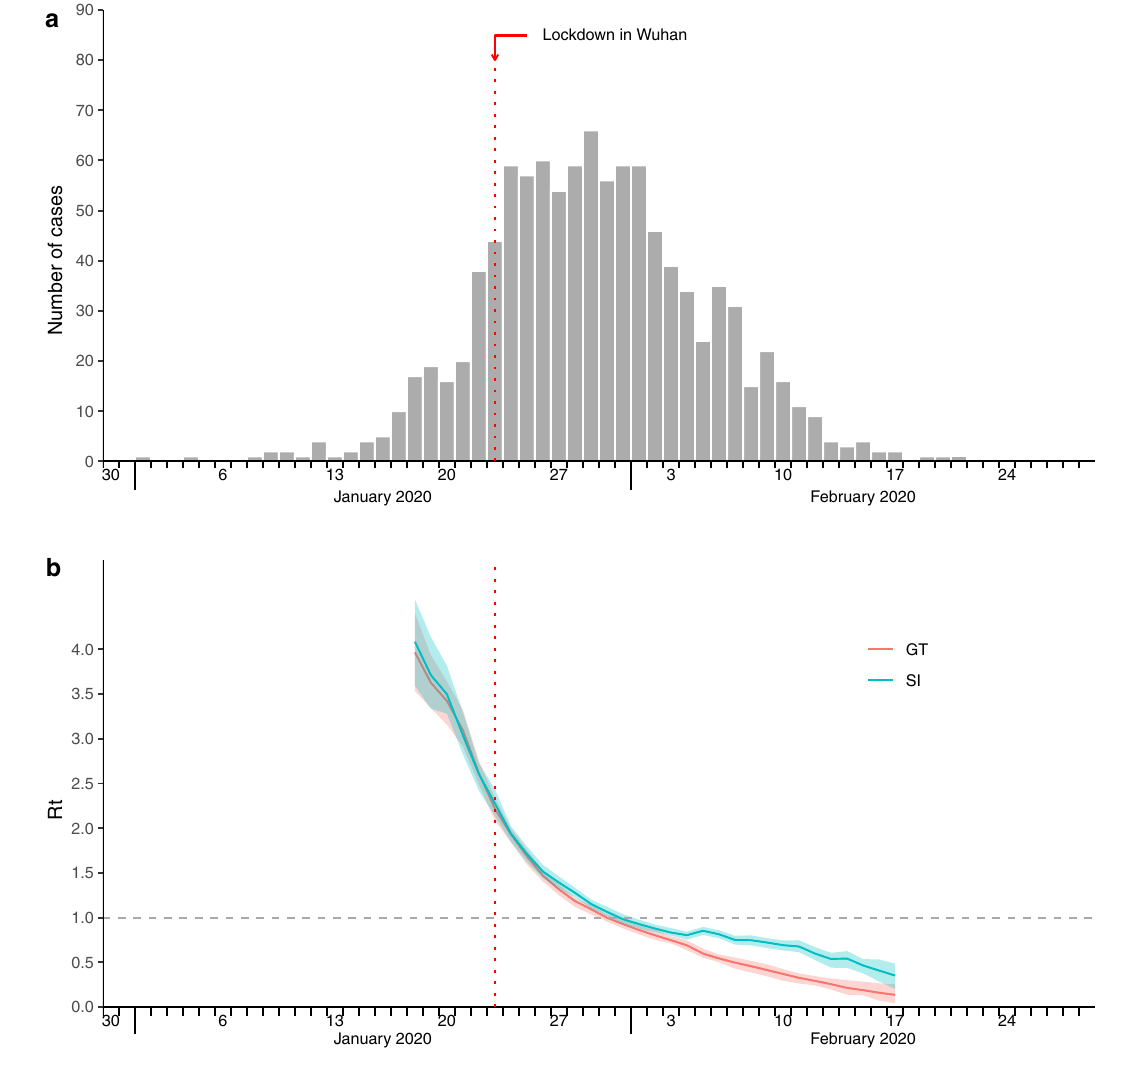
Fig. 5 | Epi-curve of observed onset times and effective reproduction numbers estimated by temporal generation time (GT) and serial interval (SI), respec- tively.a Epidemiccurveofallcasessymptomonset.Redarrowindicateslockdown in Wuhan and the implementation of public health social measures since January 23, 2020. b Case-based effective reproduction numbers estimated based on epi-